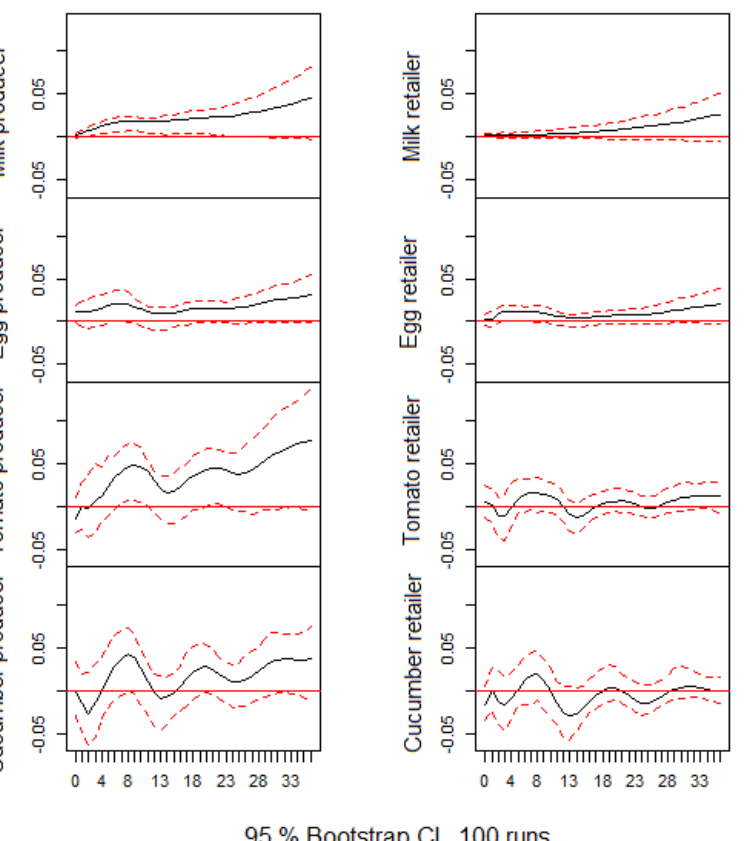
Figure 3. Orthogonal impulse response of agricultural commodity prices to diesel